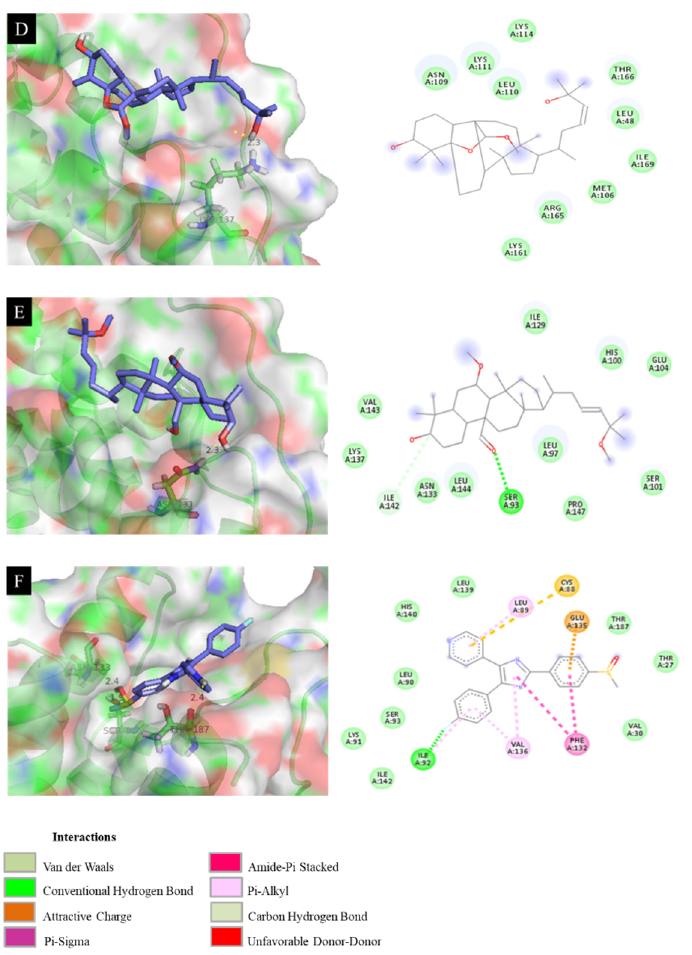
Figure 3. Docking simulation of the interactions between compounds 3 ( A ), 4 ( B ), 6 ( C ), 11 (D ), 12 ( E ), and SB203580 ( F ), respectively, and the 2L3Y protein of IL-6